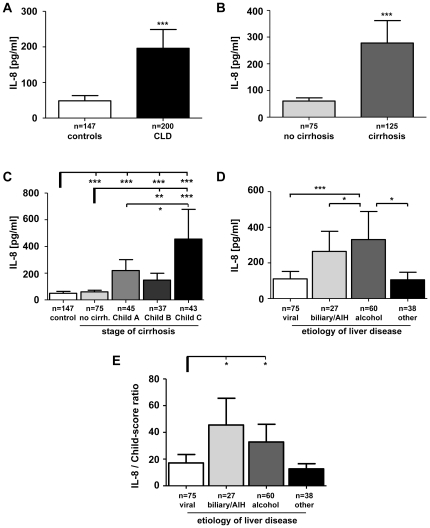
Serum IL-8 levels in healthy controls and patients with chronic liver disease.(A) Serum IL-8 levels are significantly increased in patients compared to healthy controls. (B) Cirrhotic patients show higher IL-8 serum levels than non-cirrhotics. (C) Dissecting the various stages of CLD revealed that IL-8 levels are highest in end-stage liver disease. (D) Patients with underlying alcoholic and biliary/autoimmune liver diseases showed higher IL-8 serum concentrations than viral hepatitis or other causes of CLD. (E) To normalize for the stage of cirrhosis, IL-8 serum levels were divided by the Child-Pugh score points. Elevated IL-8 in cholestatic and alcoholic liver diseases remained significant. CLD, chronic liver disease; AIH, autoimmune hepatitis.